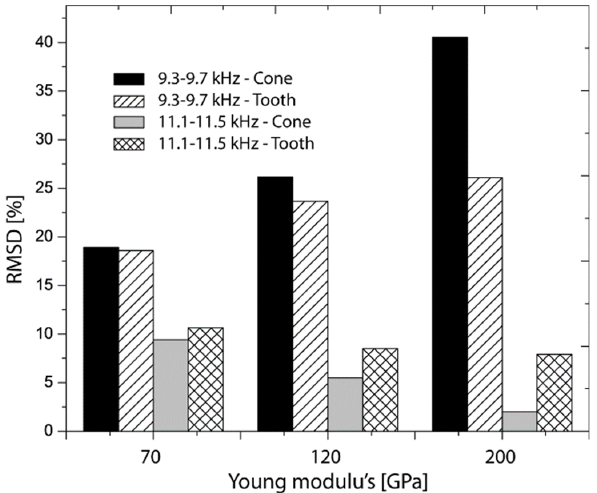
Figure 8. Root mean square deviation (RMSD) calculated for electrical resistances obtained in A-A and B-B.